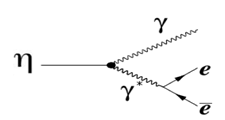
Figure 2. The Feynmann diagram of the η → e + e − γ decay.